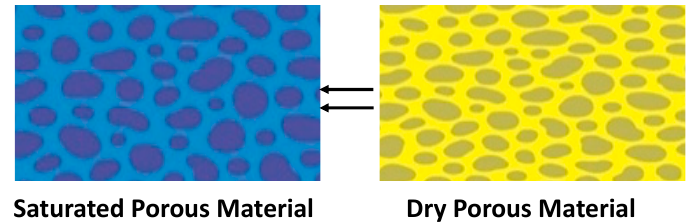
Figure 3. Schematic diagram of a harvesting atmospheric water Figure 3 . Schematic diagram of a harvesting atmospheric water system.